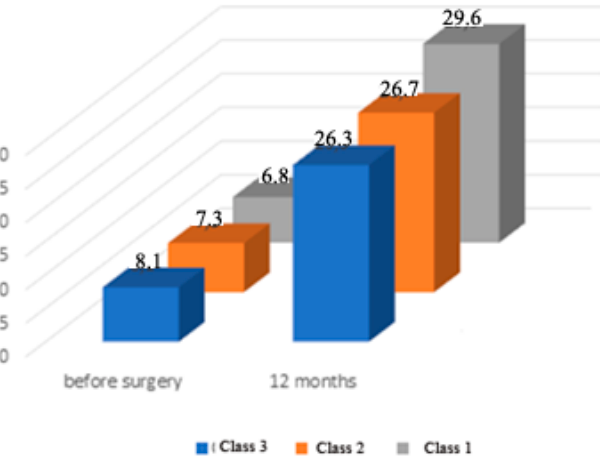
Figure 6. Stage 2—Mental health status before and 12 months after surgery. The total postsurgical complications rate was significantly lower in patients with Class 1 obesity (1.2%) compared to considerably higher and rising rates from the Class 2 to the Class 3 patients (4.8% and 17.1% respectively, p = 0.001, Table 4). The rate of superficial postsurgical infections was significantly higher in patients with Class 3 obesity than the Class 1 patients. These rates raised also in Class 2 patients but especially in Class 3 patients (2.4% and 3.6% respectively, p < 0.05, Table 4). The prosthesis dislocations, late aseptic loosening, and periprosthetic fractures occurred only in the Class 3 group (2.4%, 2.4%, and 3.6%, respectively). Neural damage did not appear in Class 1 patients but in one patient (1.2%%) in each Class 2 and Class 3 group. Table 4. Stage 2 of the